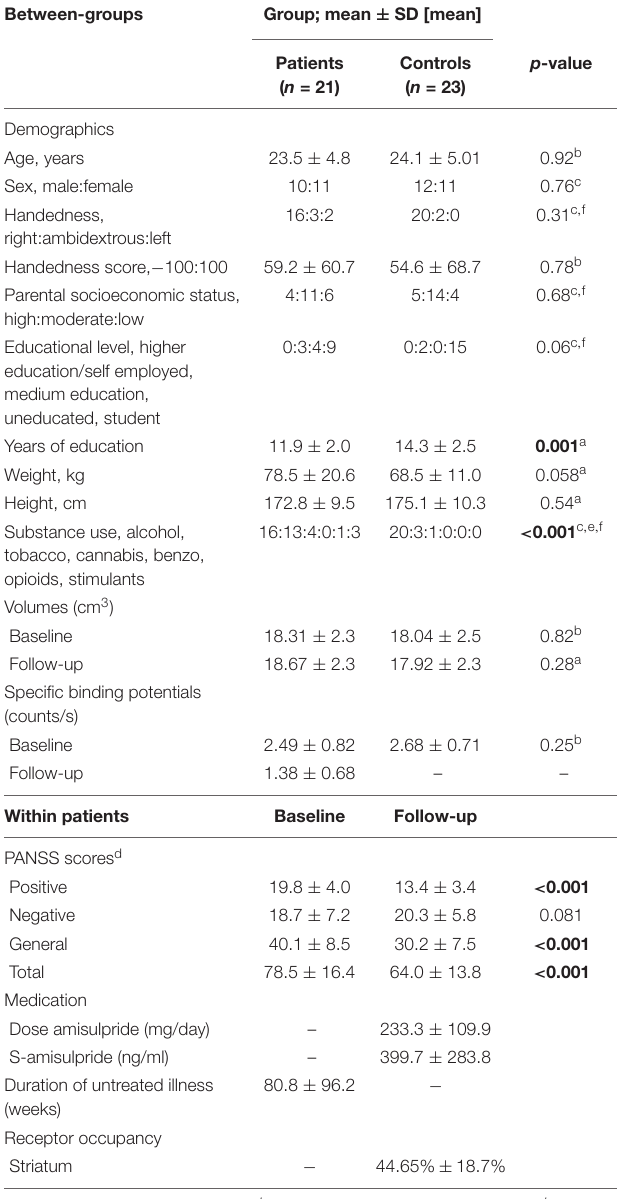
TABLE 1 | Demographic and clinical